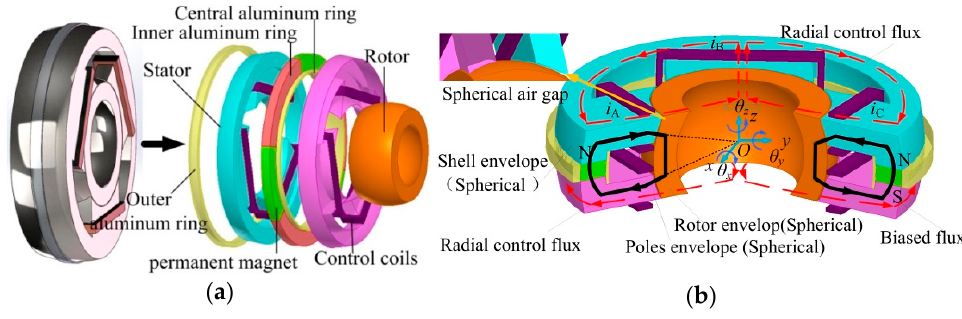
Figure 1. Structure and magnetic circuits of spherical radial AC HMB ( a ) Assembling structure and exploded view. ( b ) Sketch of the magnetic circuits.